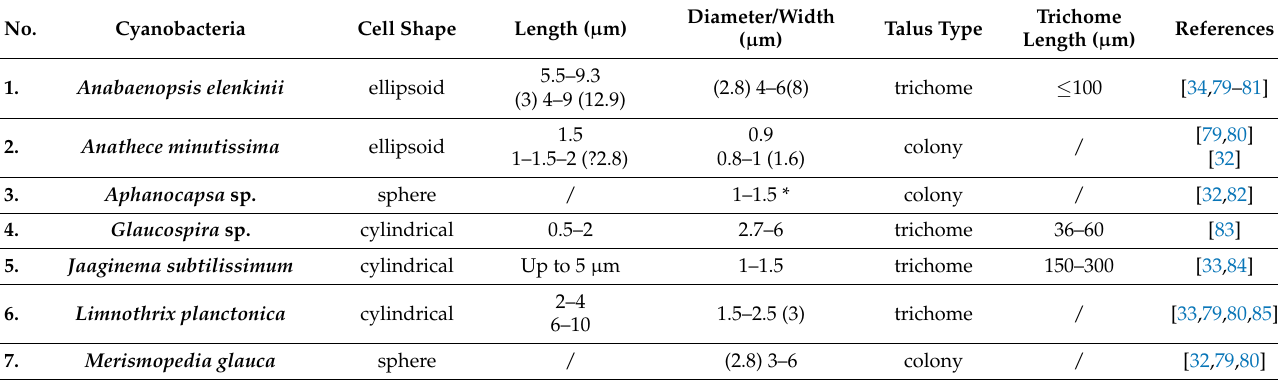
Table 7. Dimensions of cyanobacterial cells from literature